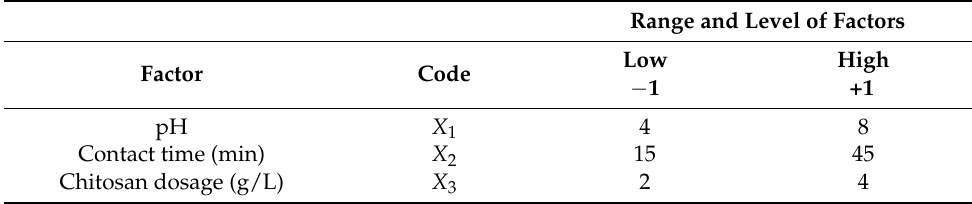
Range and Level of Factors Low High − 1 +1